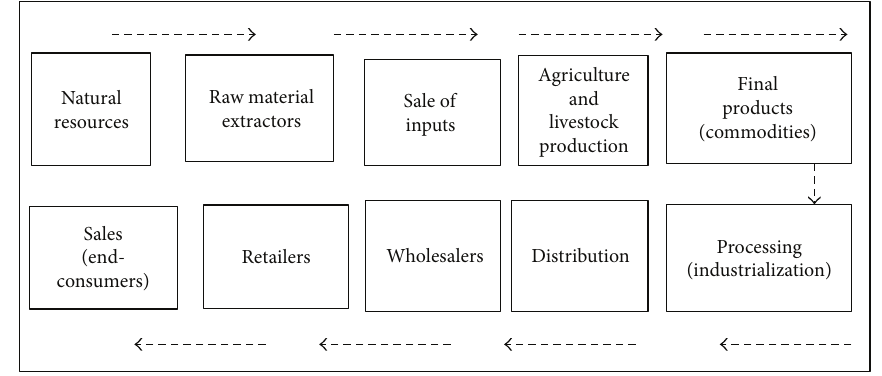
Figure 1: Agribusiness supply